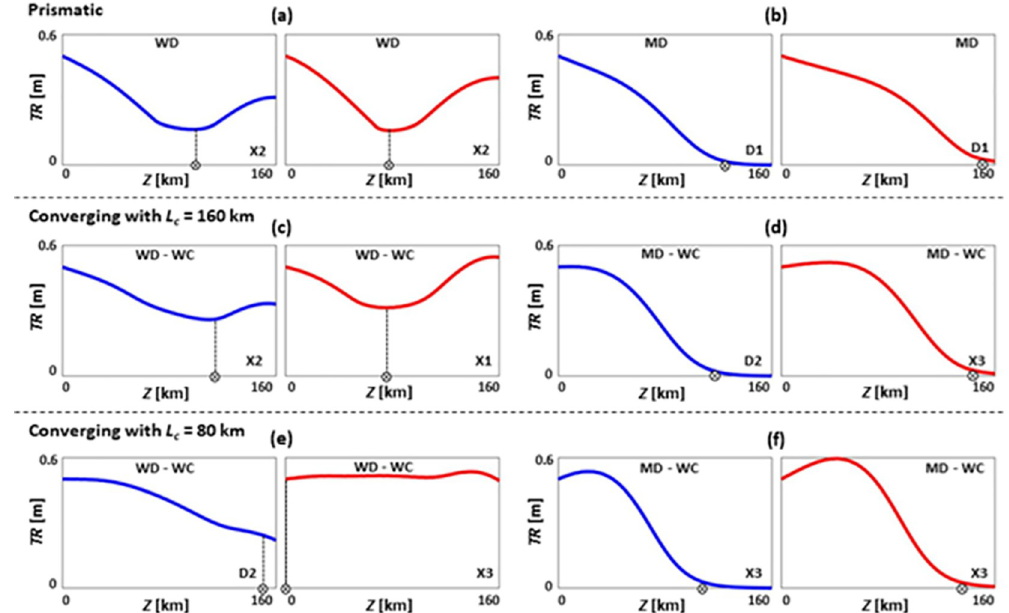
Fig 8. Influence of bed slope on tidal range TR patterns of prismatic (a, b), converging with L c = 160 km (c, d), and converging with L c = 80 km (e, f) estuaries under SLR, where TR 0 = 0.5 m, Q / TP = 5% (medium river discharge), Z = 160 km, n = 0.015 s/m 1/3 , and h = 5 m. Cases in (a), (c), and (e) have flat beds ( θ = 0˚), and in (b), (d), and (f) have sloped beds ( θ = 0.002˚). Blue and red colours show base case (no SLR) and 1 m of SLR scenarios, respectively. Patterns X1, X2, X3, D1 and D2 are the general TR patterns introduced in Fig 2. WD, MD, and WC refer to weakly dissipative, moderately dissipative, and weakly converging estuaries,